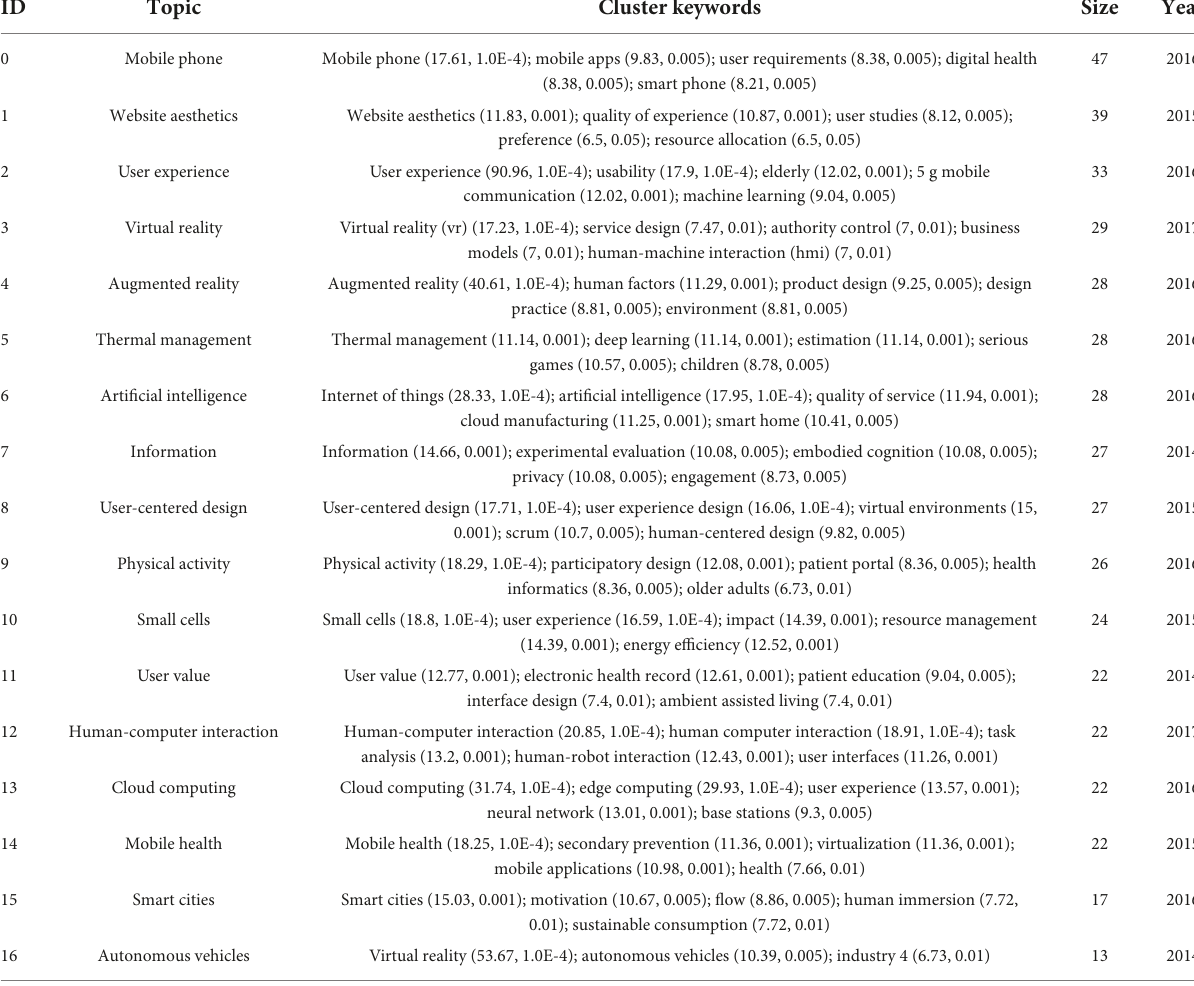
TABLE 4 Keywords clustering network